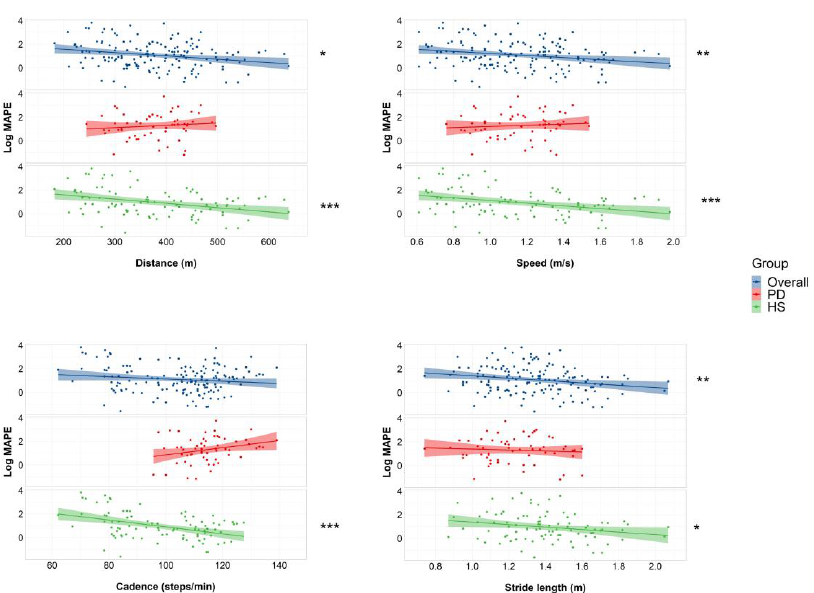
Figure 2. Scatterplots showing association between spatiotemporal gait parameters and MAPE. Scatterplots are presented for the overall population (all participants, PD + HS) (upper grid panels, in blue), PD patients (middle grid panels, in red), and healthy participants (bottom grid panels, in green). MAPE is reported as logarithm. A continuous line was drawn to show the linear tendency. The shaded area around the tendency line corresponds to the 95% confidence interval. Significance is reported as follows: * p < 0.05; ** p < 0.01; *** p < 0.001. HS: Healthy subjects; MAPE: Mean absolute percentage e rror; PD: Parkinson’s disease.